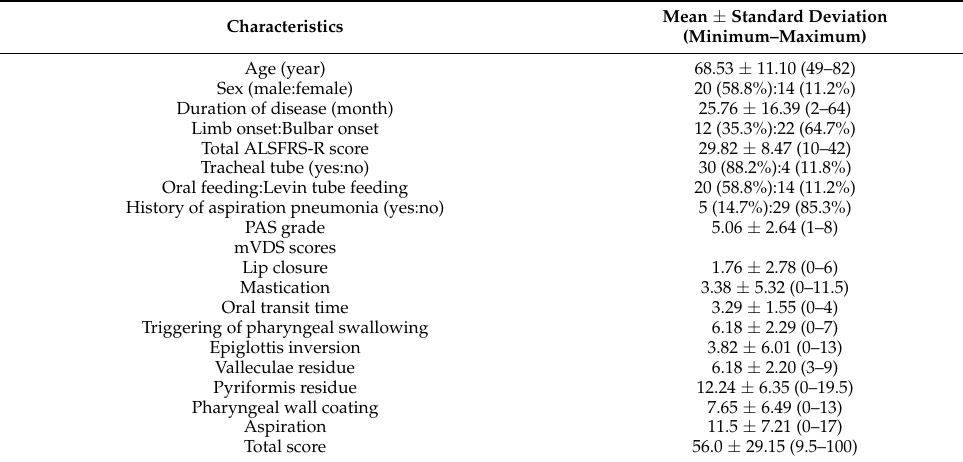
Table 2. Characteristics of ALS patients with dysphagia in the present